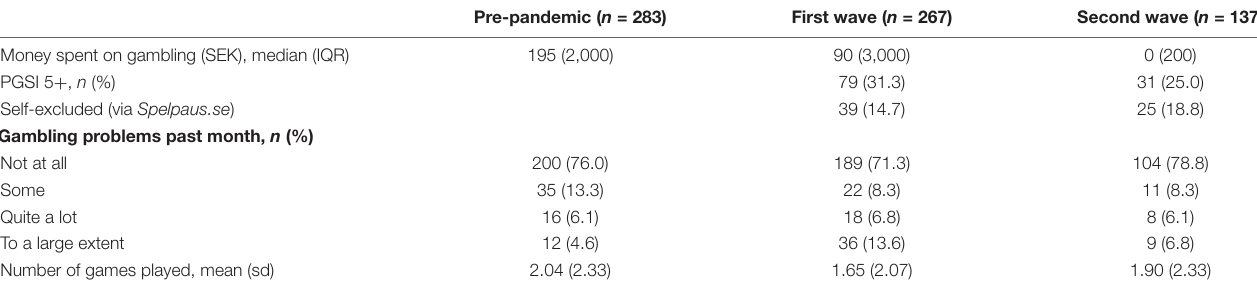
TABLE 2 | Gambling-related variables.